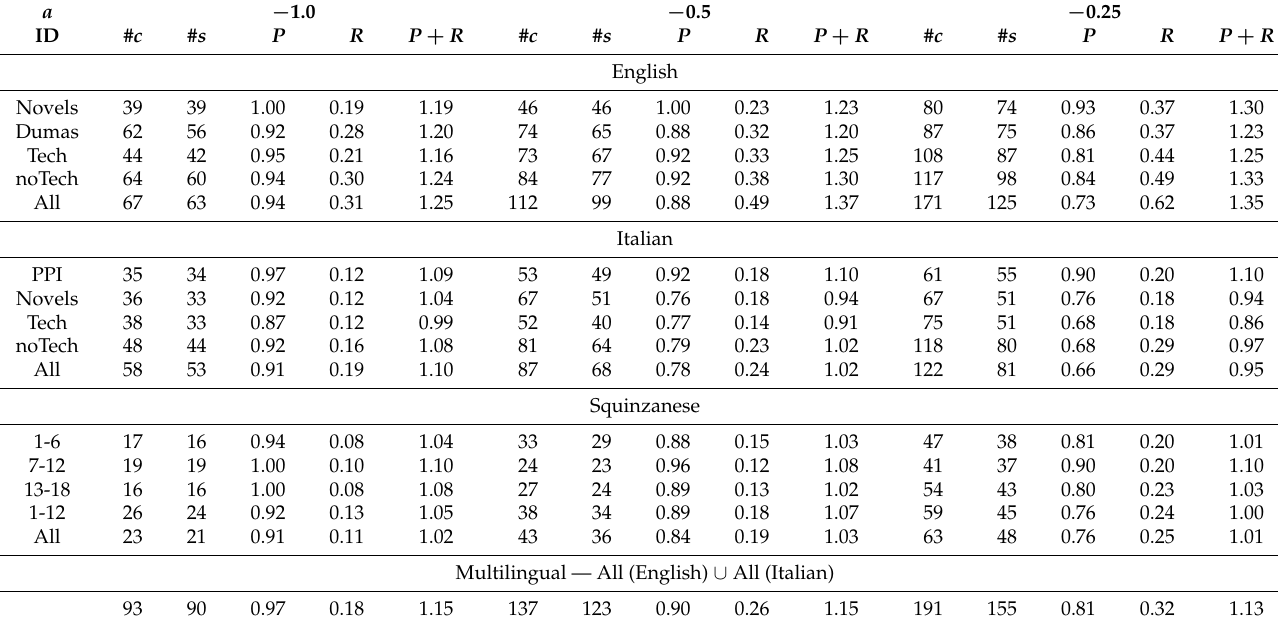
Table 11. TDF outcomes on sets of